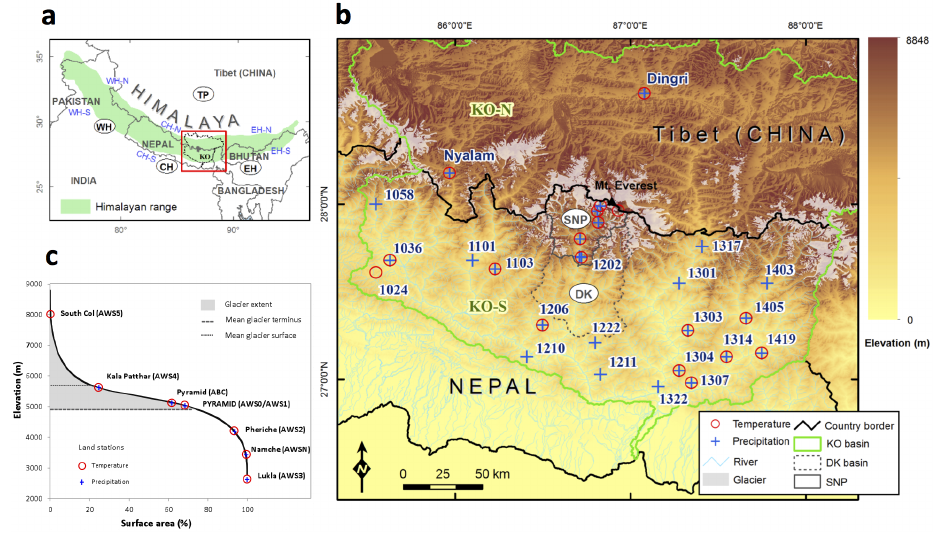
Figure 1. (a) Location of the study area in the Himalaya, where the abbreviations WH, CH, EH represents the western, central and eastern Himalaya, respectively (the suffixes -N and -S indicate the northern and southern slopes). (b) Focused map on the spatial distribution of all meteorological stations used in this study, where KO and DK stand for the Koshi and Dudh Koshi Basins, respectively; SNP represents the Sagarmatha National Park. (c) Hypsometric curve of SNP (upper DK Basin) and altitudinal glacier distribution. Along this curve, the locations of meteorological stations belonging to PYRAMID Observatory Laboratory are